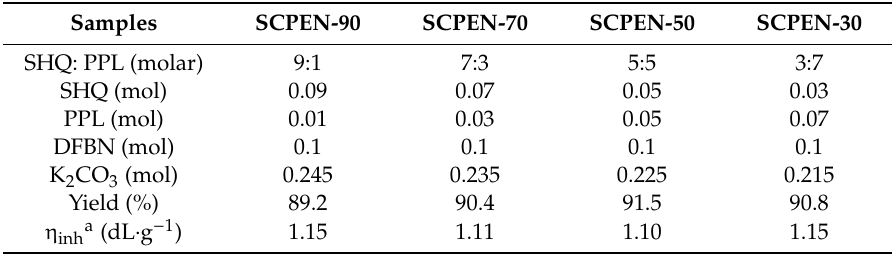
Table 1. Components of SCPEN